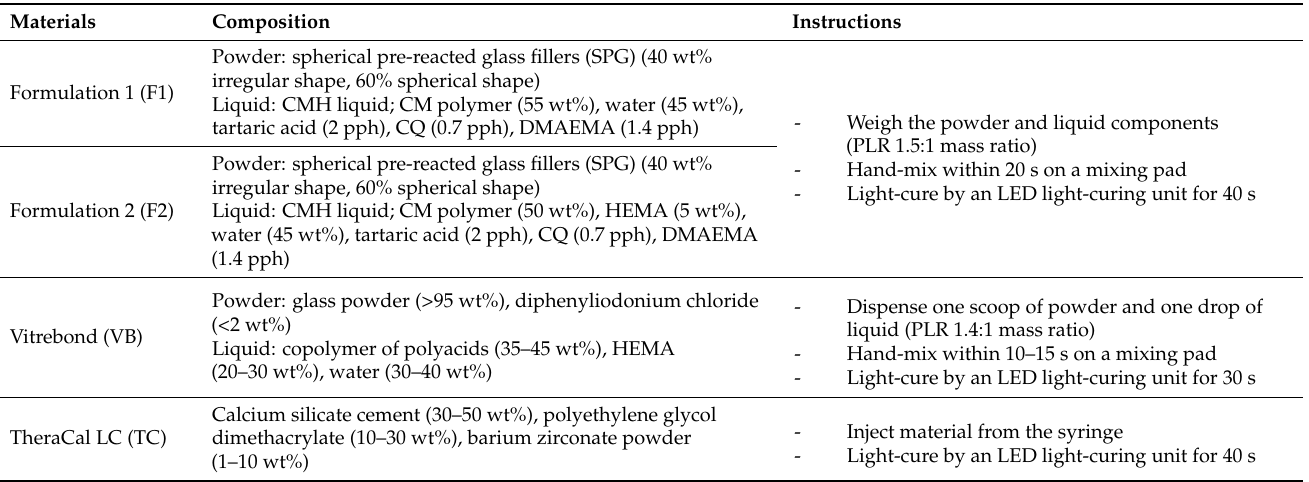
Table 1. Composition of materials used in the current study (pph means parts per hundred). Materials